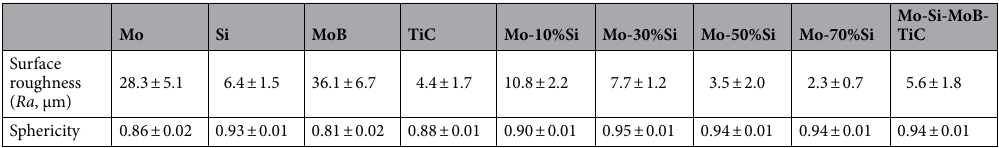
Multicomponent FD‑POEM particles. A spherical multi-component particle of MoSiMoTiC was also prepared (see Fig. 8a). As confirmed by SEM–EDS mappings (see Fig. 8b–e), elemental Mo, Si, and Ti were evenly distrib- uted on the particle surface. Figure 8f shows the particle size distribution of the MoSiBTiC particles fabricated by FD-POEM. It can be seen that the size distribution is within a narrow range and follows a typical Gaussian curve. The particle size d 50 was determined to be 745 μm. In addition, the powder flowability of FD-POEM particles was reflected by a revolution method, where lower avalanche angles indicated better flowability. The avalanche angle of the FD-POEM MoSiBTiC particles